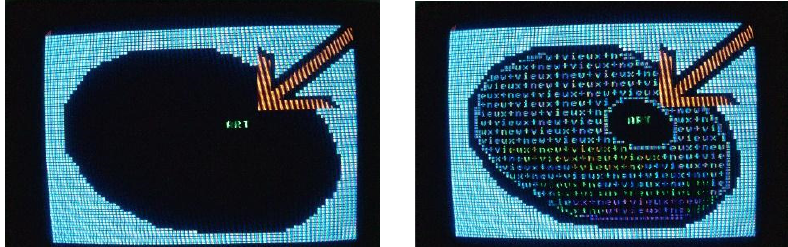
Figure 5. Images from “Sainte-ORLAN-au-sein-provocant”, project by the artist ORLAN for Art Accès . Collection Les Immatériaux © Kandinsky Library, MNAM/CCI, Centre Pompidou.